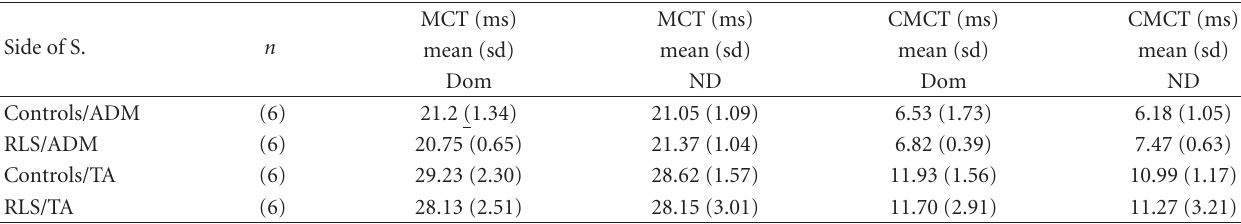
Table 1: Motor conduction time (MCT) and central motor conduction time (CMCT) in abductor digiti minimi (ADM) and tibialis anterior (TA) muscles did not di ff er between the subjects with RLS and controls. The results were measured on the contralateral body side after transcranial magnetic stimulation (TMS) on the dominant (Dom) and nondominant (ND) motor cortex areas. Side of S.